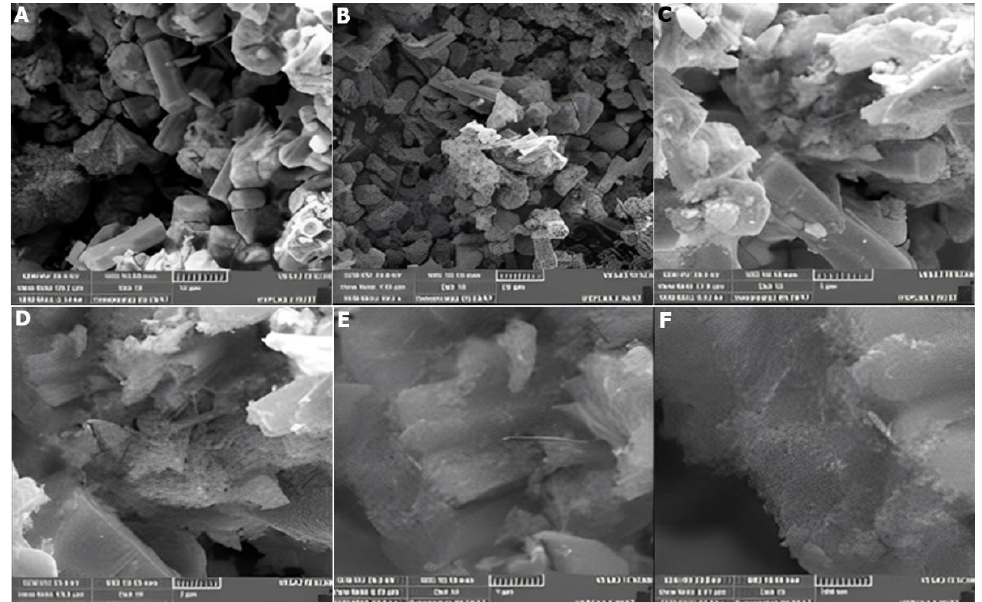
Figure 13. SEM images of ZnO/GO nanocomposite grown by the CBD method ( A )—10 µm, ( B )—20 µm, ( C )—5 µm, ( D )—2 µm, ( E )—1 µm, ( F )—0.5 µm.